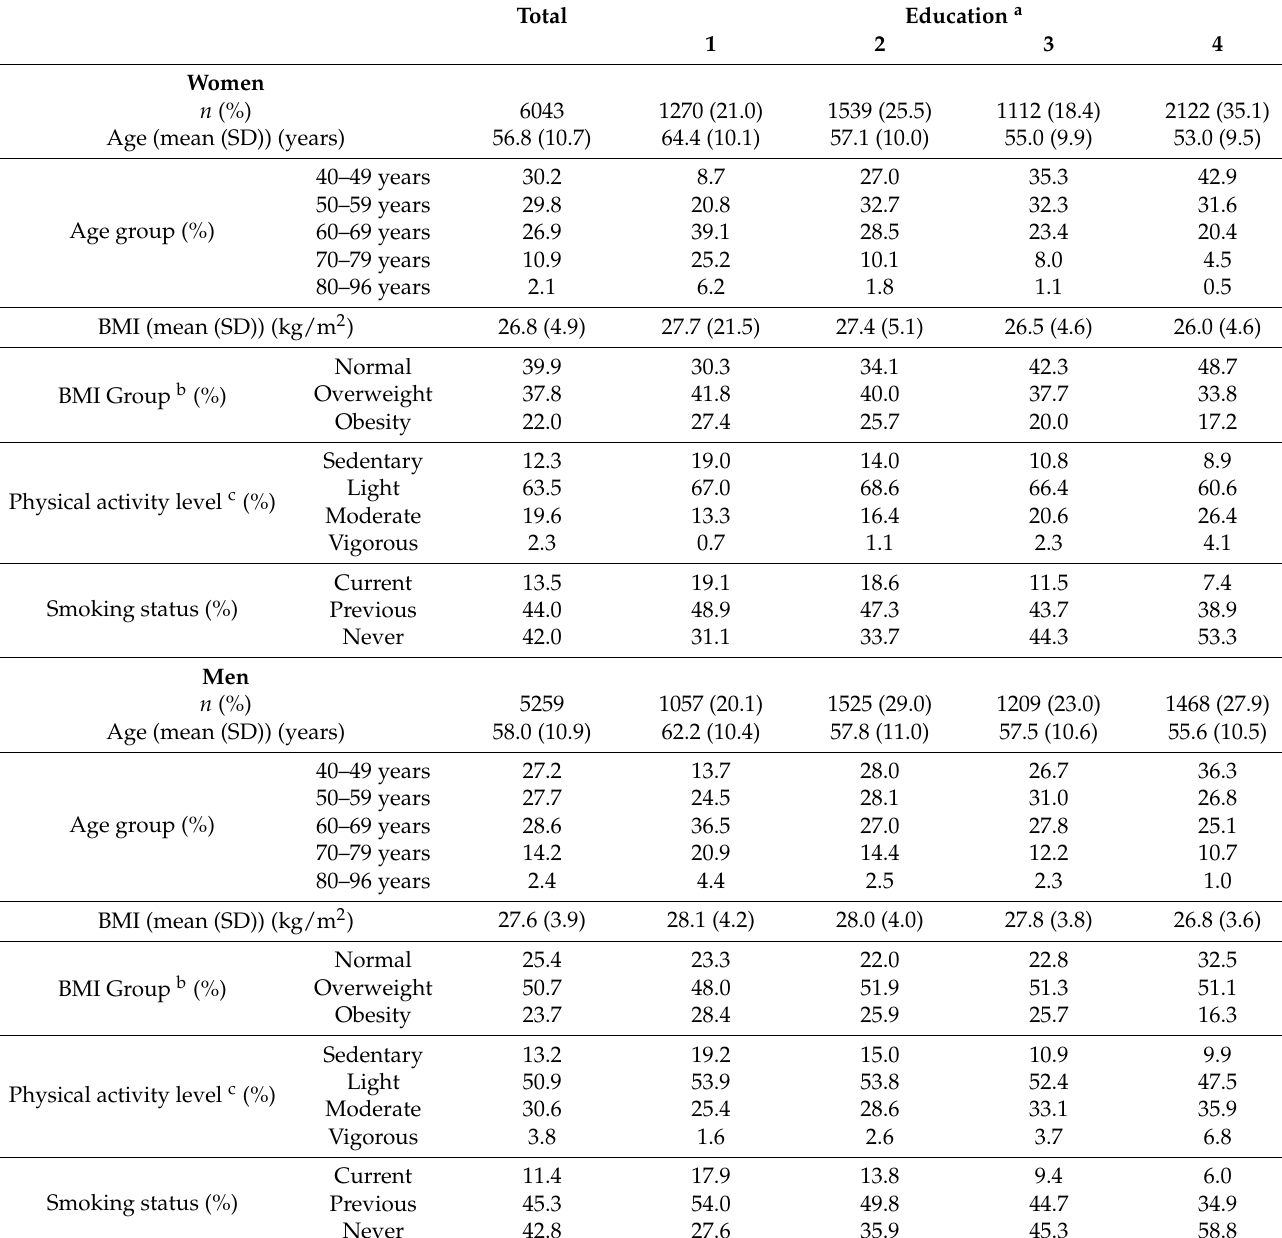
Table 1. Characteristics of study sample by sex and education level. The Tromsø Study